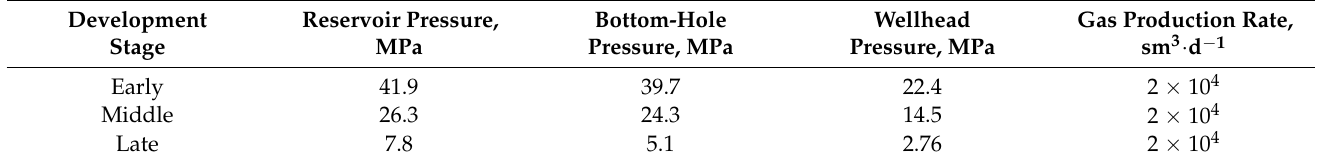
Table 6. Well productivity